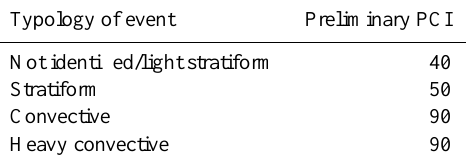
Table 2. Preliminary PCI based on precipitation